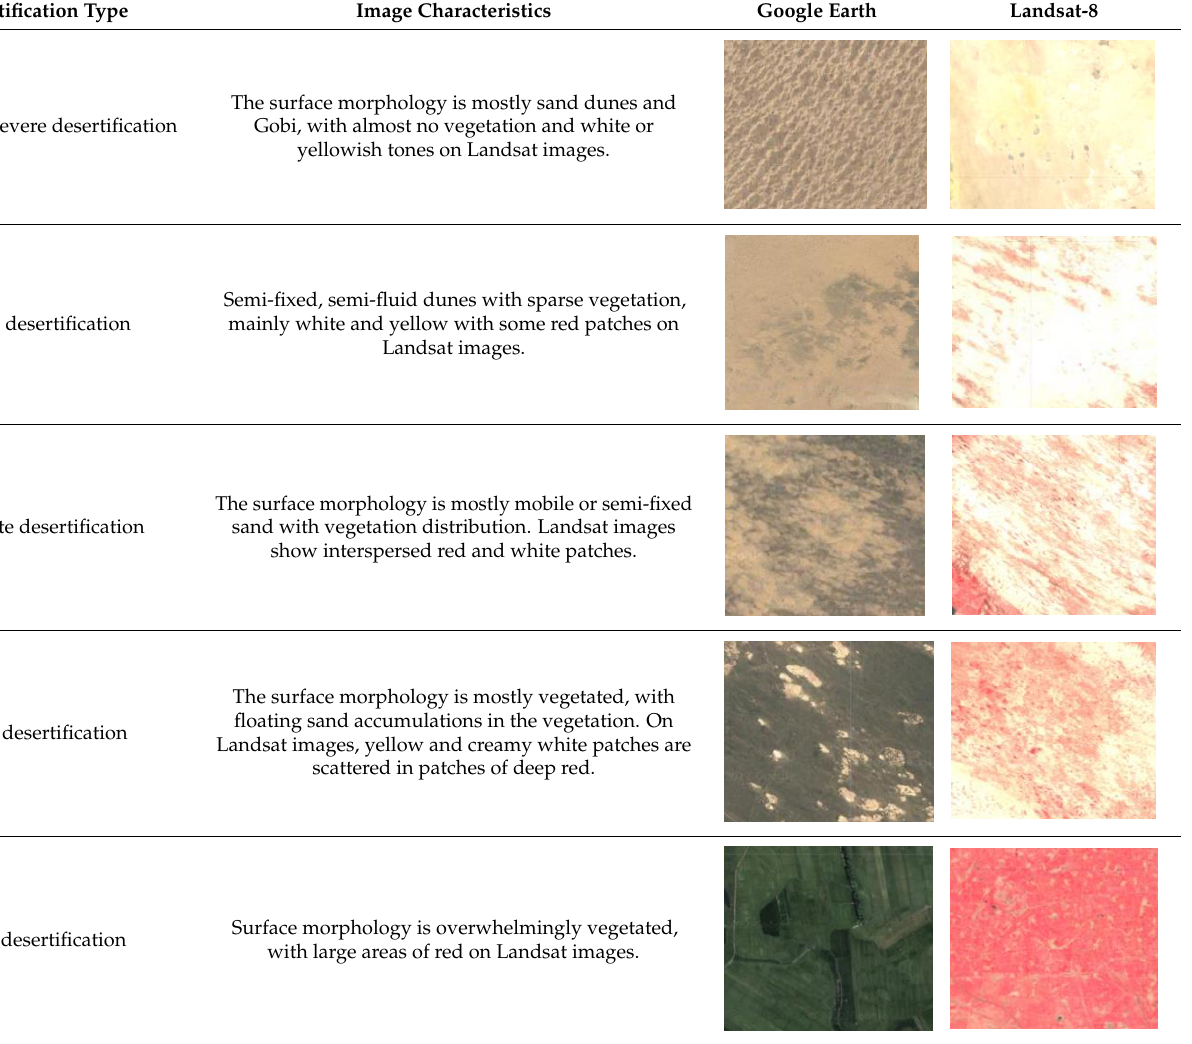
Table A1. Characteristics of different desertification types.